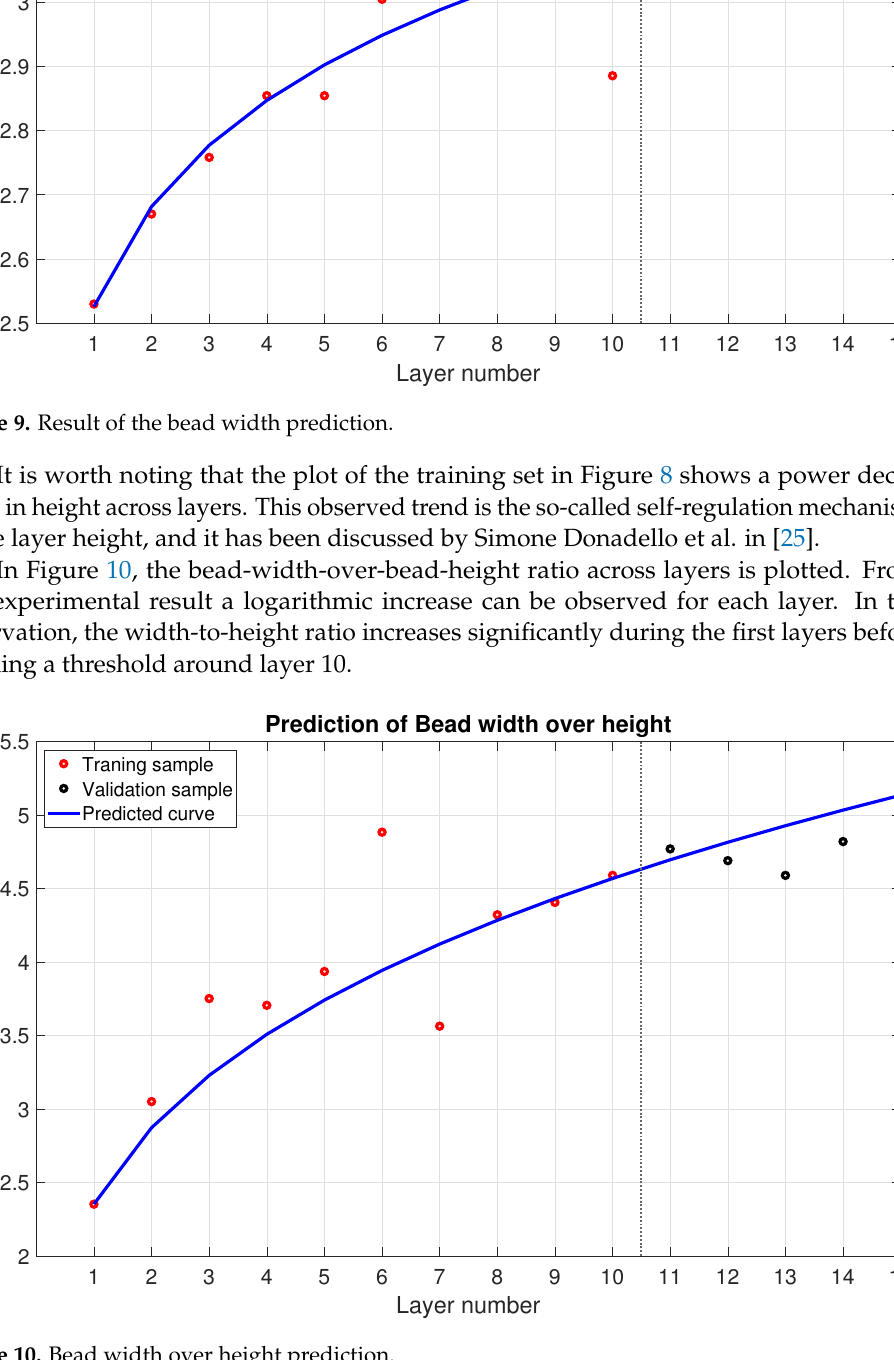
Figure 10. Bead width over height